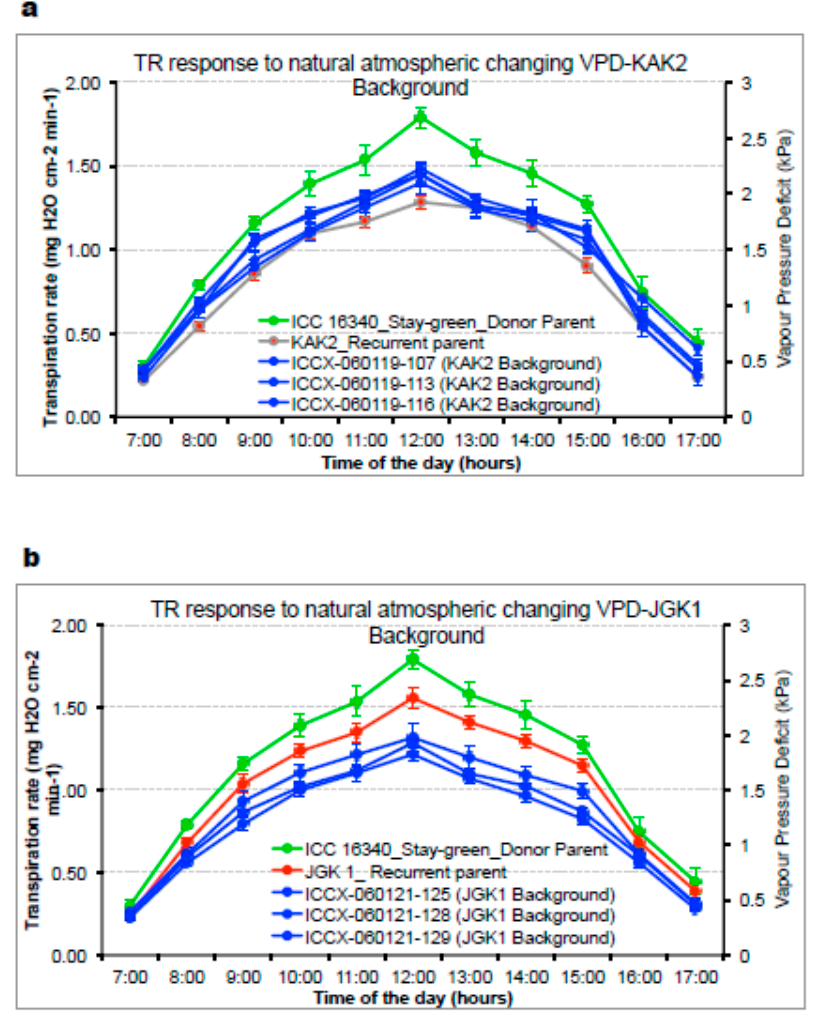
Figure 4. Transpiration rates (TR) of stay green chickpea introgression lines (ILs) with different genetic backgrounds of KAK2 elite cultivar ( a ), and 4JGK1 elite cultivar ( b ). Stay green donor parent (DP) ICC 16,340 (round with solid green line); Recurrent parent (RP) KAK2 (round with solid red line); KAK2 background introgression lines ICCX-060119-107, ICCX-060119-113, ICCX-060119-116 and ICCX-060119-123 (round with solid blue line); Recurrent parent (RP) JGK1 (round with solid red line); JGK1 background introgression lines ICCX-060121-125, ICCX-060121-128 and ICCX-060121-129 (round with solid blue line)] are response to natural changing in the atmospheric vapour pressure deficit (VPD) cycle. TRs were measured on well-watered plants grown in the glasshouse, which were temporarily transferred to outdoor conditions. There, plants were exposed to natural changing atmospheric VPD. TR and VPD data were used to draw a segmental or a single linear regression for all tested genotypes. Each data points represents the means (± SE) of eight replicates per genotype.